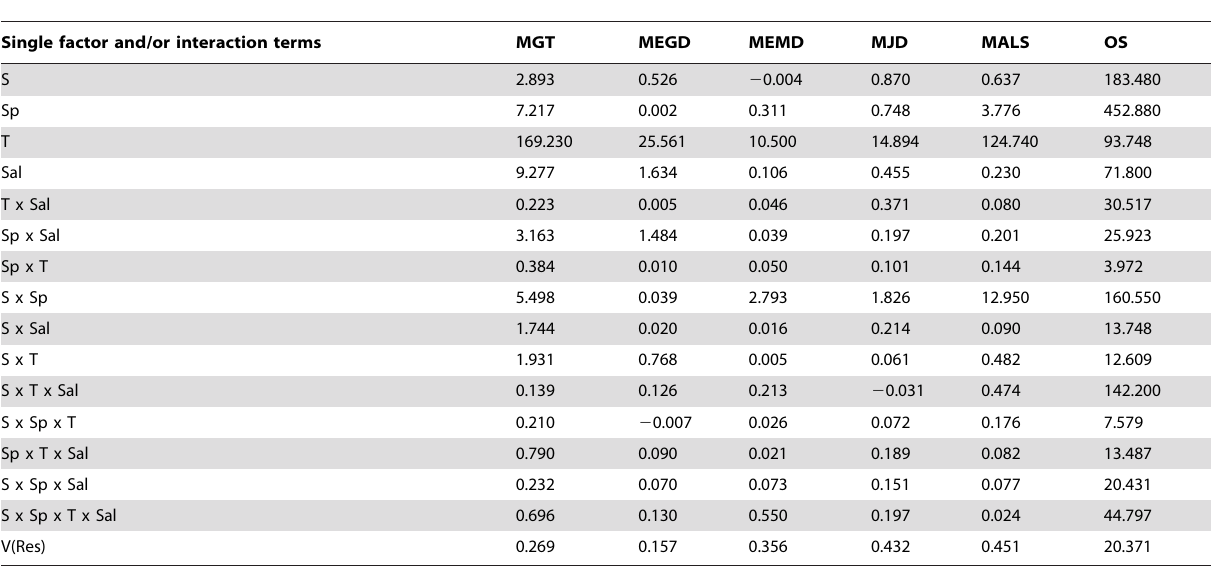
Table 2. Estimates of components of variation results of the four-way PERMANOVA on single factors and interaction terms for all analyzed variables.